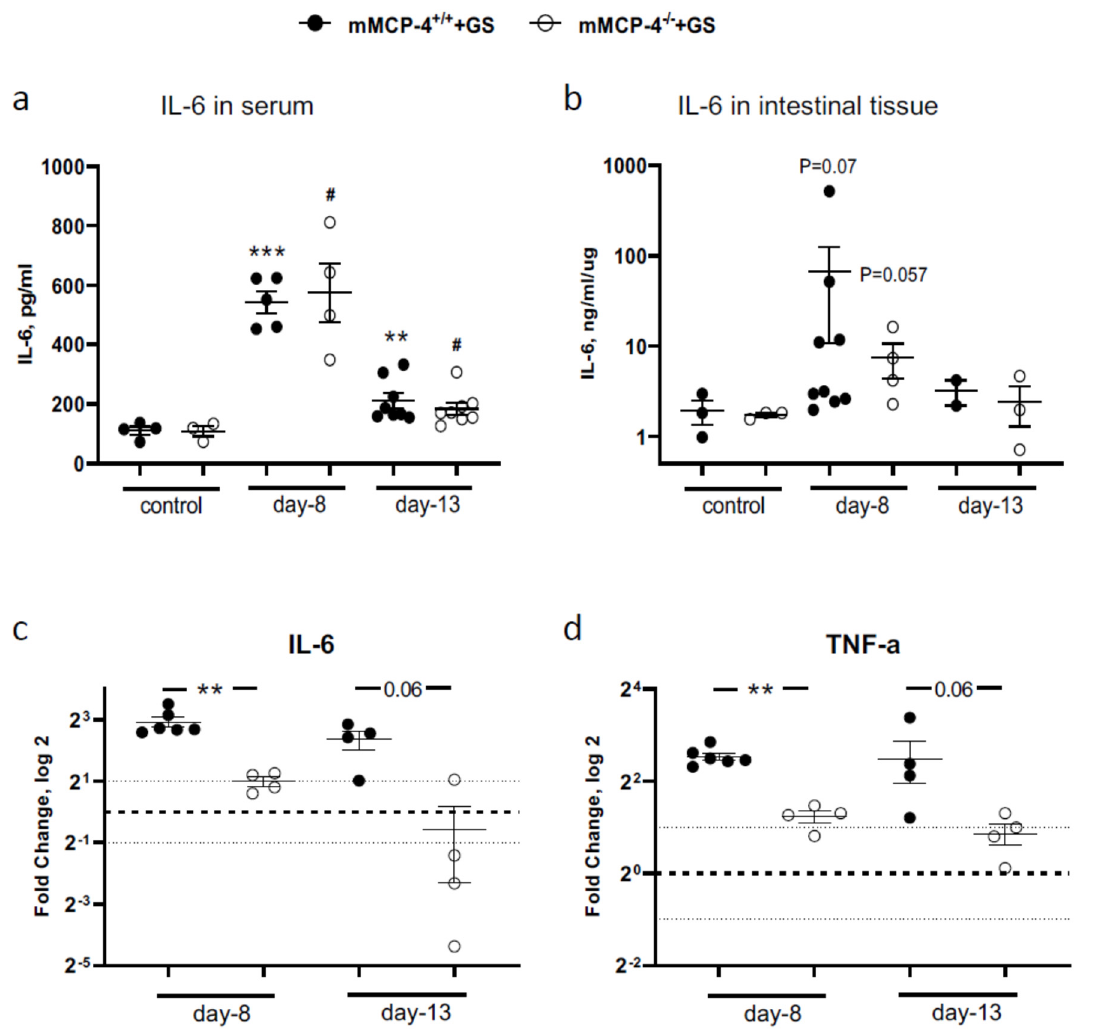
Figure 4. Pro-inflammatory cytokine expression levels in mMCP-4 +/+ and mMCP-4 − / − mice infected with Giardia intestinalis . IL-6 protein levels were measured by ELISA in > 18-week-old mice in ( a ) serum and ( b ) intestinal tissue homogenates from experiments #2 or #3a, and #6. Intestinal mRNA expression levels (qPCR) of IL-6 ( c ) and TNF- α ( d ) in Giardia -infected > 18 weeks old mice from experiments #2, #3a and #6. Fold changes were calculated after normalization to GAPDH. The dotted line is at 1 and indicates no fold change. In a) **, *** indicate p < 0.01 or 0.001 vs. non-infected mMCP-4 +/+ mice and # indicates p < 0.05 vs. non-infected mMCP-4- / -mice. In (c) and (d), ** indicates p < 0.01 for mMCP-4 +/+ vs. mMCP-4 − / − mice.